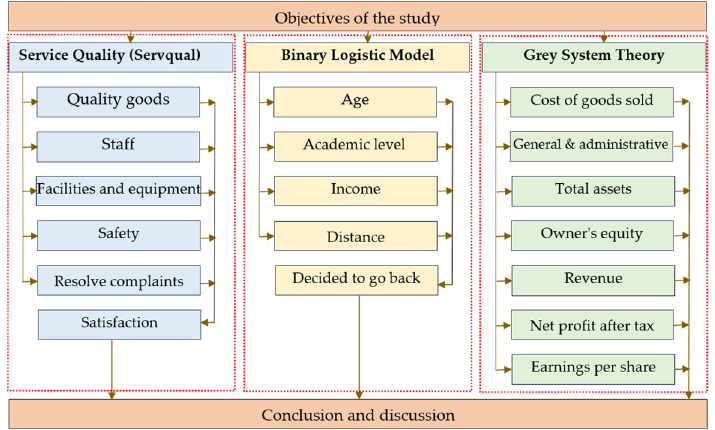
Figure 5. Research